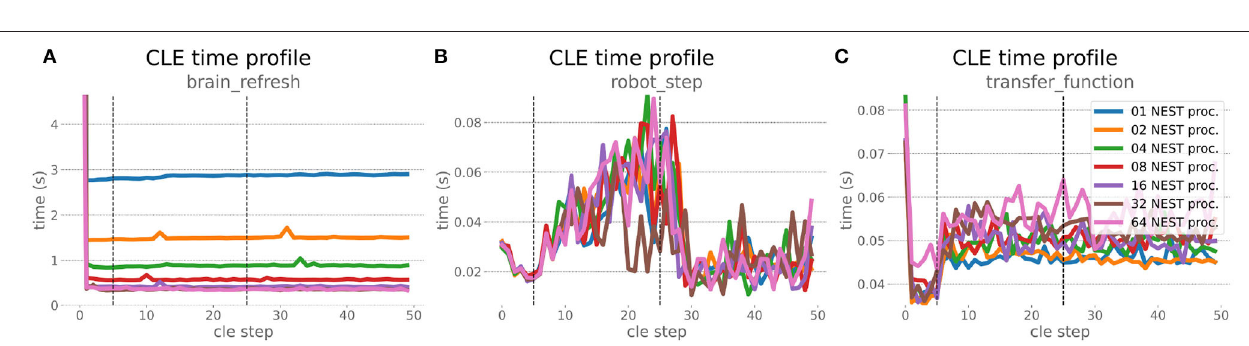
FIGURE 12 | Embodied multi-region rodent brain benchmark CLE profiler times. Experiment execution has an impact on step times, setting the spike ratio of a motor cortex layer at step 5, and feeding the brain at 25 steps has a visible effect in Transfer Function (C) and robot (B) execution. Transfer Functions execute slightly slower with scaling up the experiment, but is still small compared to the large improvement in the brain execution times (A) . The first timestep includes additional initialization procedures and hence takes significantly longer than the usual runtime step time, in the diagrams we clip the y-axis for better visibility of the relevant runtime